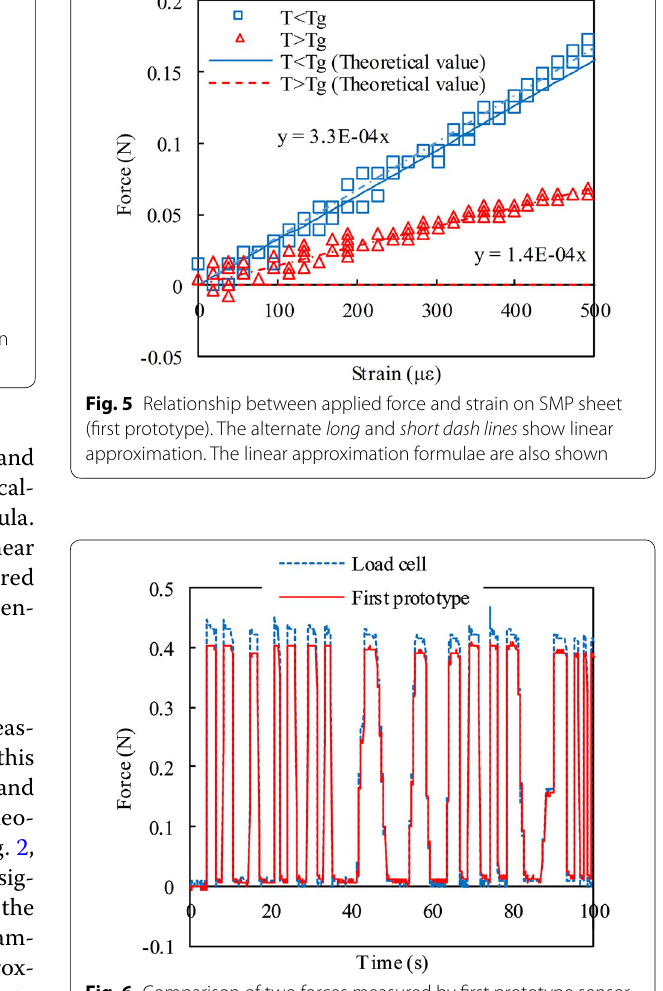
Namely, our sensor can accurately measure the applied force. In Figs. 6 and 7, the absolute average differences between the two forces are 0.0081 and 0.021 N, respec- tively. The differences correspond to 1.7 and 21% of each maximum measured force, respectively. As shown in Fig. 7, the difference between the two forces gradually increased above T g . One reason is the creep deformation of the SMP sheet. Another reason is that the SMP sheet could not recover to the initial shape quickly because of the viscosity of the SMP sheet, and the load could not accurately measure the force. Creep and stress relaxation are large in the SMP. Therefore, we will consider the effects of the viscous term and modify Eq. (3) in future studies.